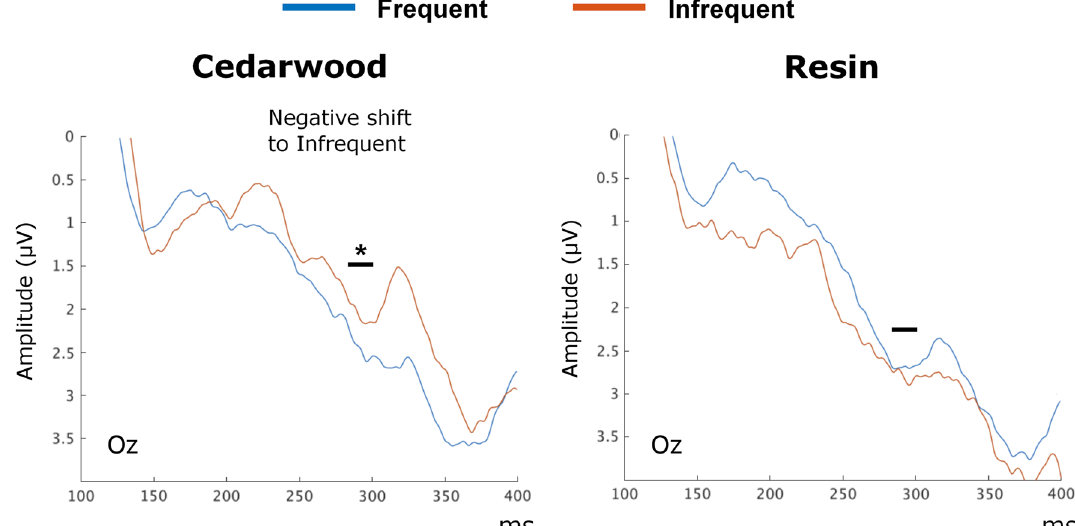
Fig. 5 Waveforms of the occipital negativities at the mid-occipital site (Oz) in the middle latencies. The occipital negativities to infrequent stimuli were observed under the cedarwood condition, especially at 280–300 ms ( p < 0.05) (left column), whereas they were not elicited in any time window at Oz under the resin condition (right